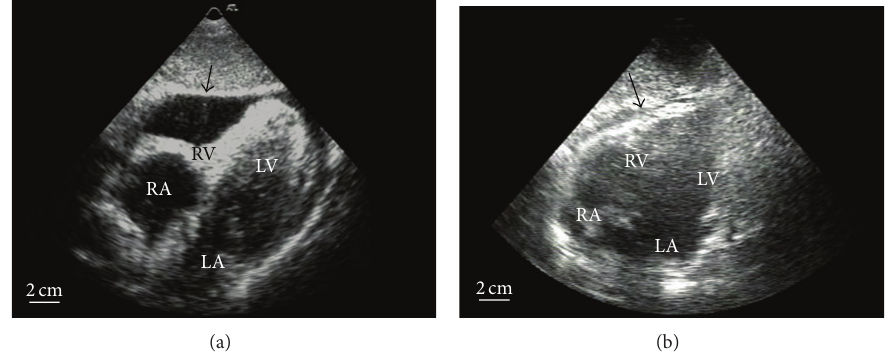
Figure 1: (a) Before treatment: pericardial tamponade with hemodynamic relevance on right ventricle (see arrow). (b) After successful treatment: a stable minor pericardial effusion without hemodynamic relevance (see arrow). RA: right atrium; RV: right ventricle; LA: left atrium; LV: left ventricle.